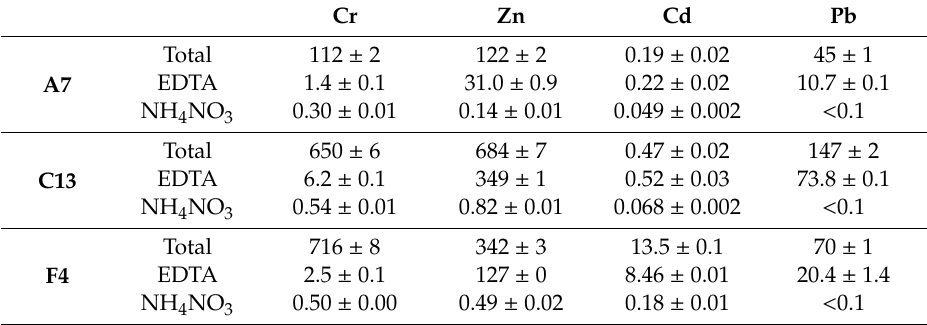
Table 1. Total, potentially bioavailable (EDTA) and readily bioavailable (NH 4 NO 3 ) concentrations (mg kg − 1 ± standard deviation) of Cr, Zn, Cd, and Pb in the soils from A7, C13 and F4 sub-areas. Cr Zn Cd Pb